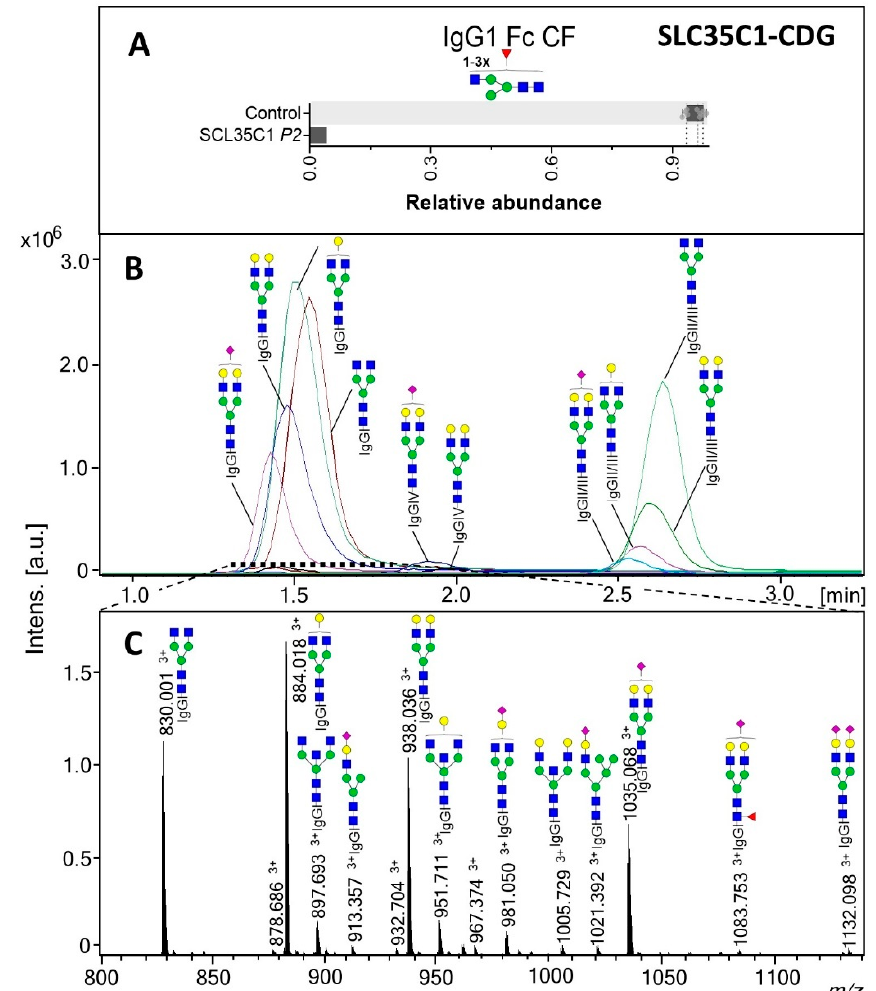
Figure 3. IgG1 Fc glycosylation for SLC35C1-CDG (P2). ( A ) Fucosylation (CF) of the IgG1 Fc portions. The box plot shows the median (dashed line) with the interquartile range (dotted lines) for healthy controls ( n = 10) whilst the bar gives the value determined for the patient. ( B ) Extracted ion chromatograms (EIC) of selected glycoforms of the different IgG subclasses and ( C ) sum spectrum of the indicated window (1.3–1.8 min; IgG1 cluster) from the LC-MS analysis of the patient SLC35C1-CDG tryptic IgG Fc glycopeptides. The proposed glycopeptide structures are based on fragmentation and literature. All glycopeptide signals annotated in ( C ) were [M+3H] 3+ . For glycan structure schemes see Figure 1.